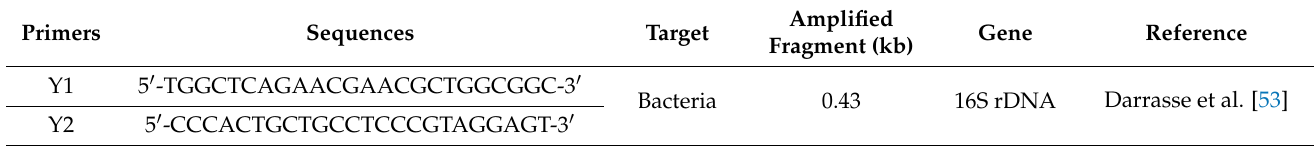
Table 5. Primers used in this